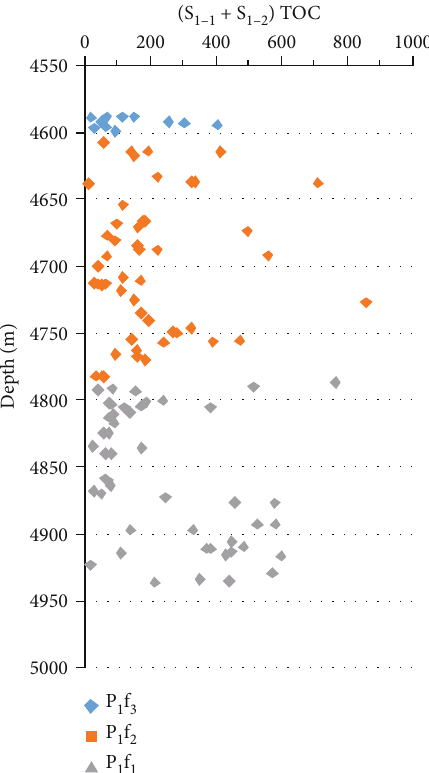
Figure 12: Variation of oil saturation with depth in the Fengcheng Formation